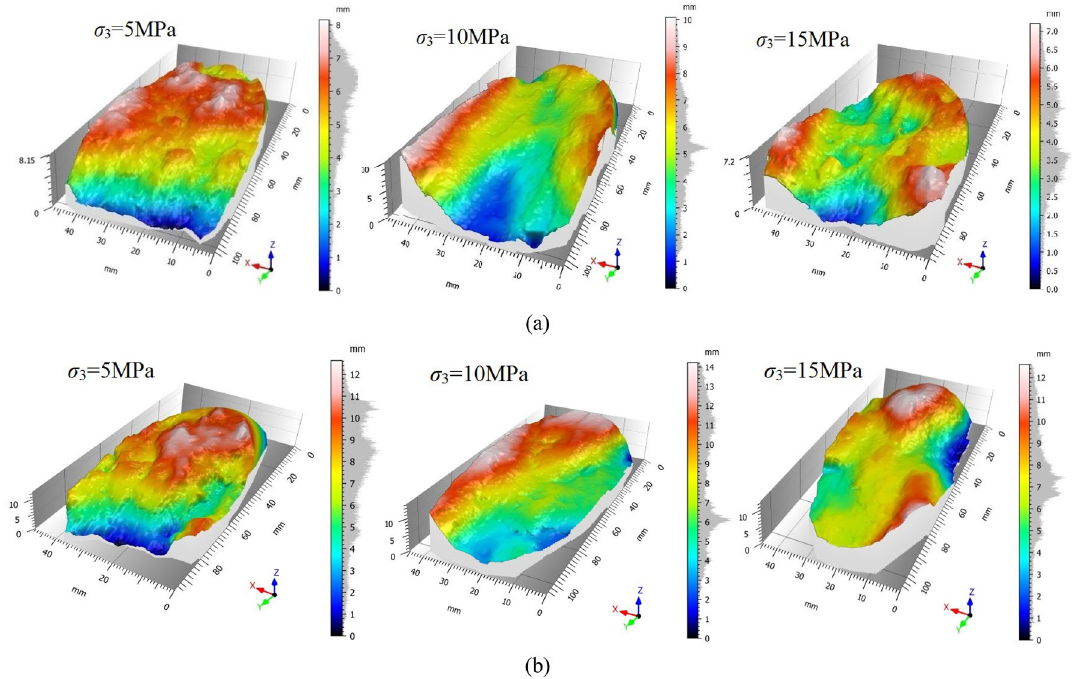
Figure 7. Three-dimensional topography of fracture surface: ( a ) triaxial loading test, ( b ) triaxial unloading